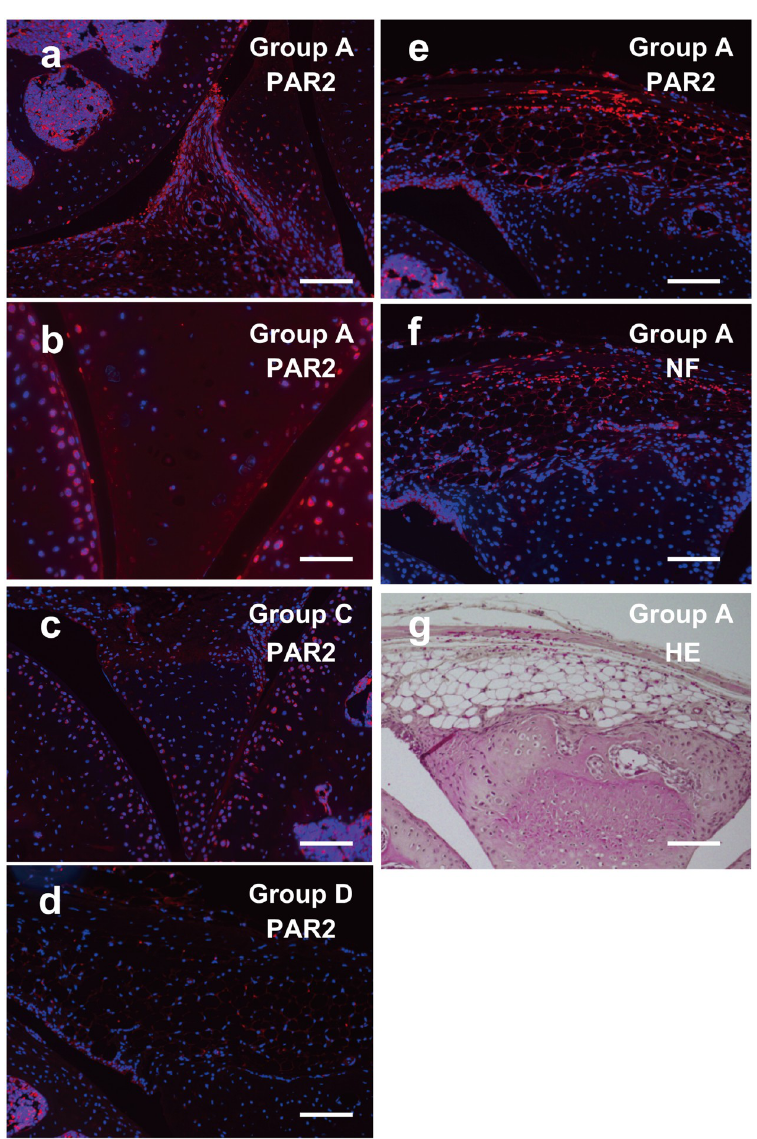
Fig 9. Expression of PAR2 in the OA knee joints. Knee joints from group A (a, b, e–g), group C (c) and group D (d) were excised 3 h after injection of BMMCs (a–c, e and f) or PBS (d) on day 14 and stained with anti PAR2 antibody (a– e), anti-NF-H antibody (f) or hematoxylin-eosin (g). Neighboring sections were stained in e-g. Original magnification was x200 (a, c–g) and x400 (b). Bars indicate 100 μ m (a, c–g) and 50 μ m (b).